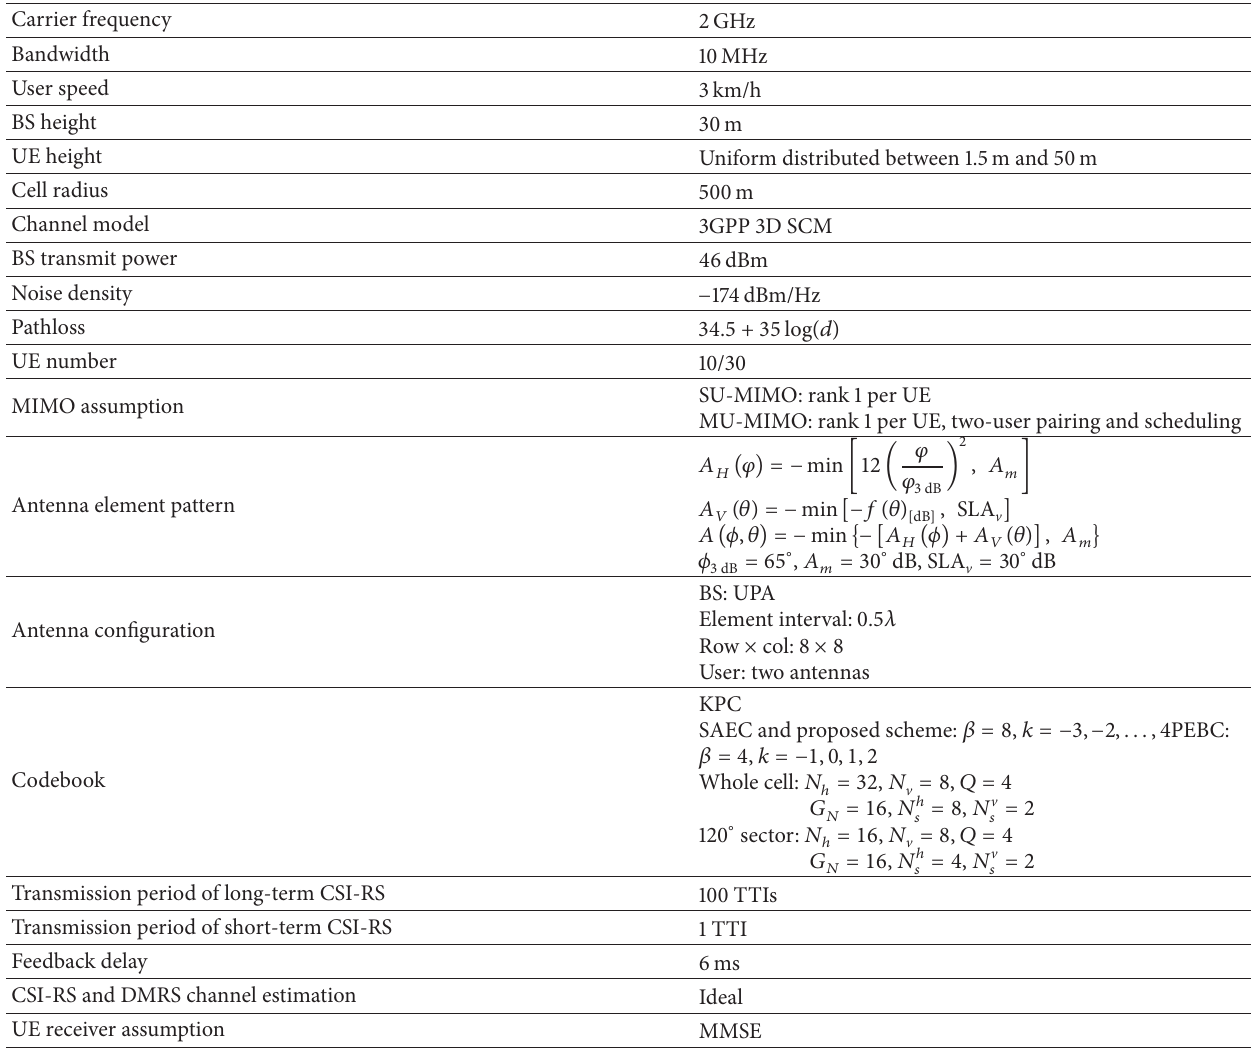
Table 1: Simulation parameters.